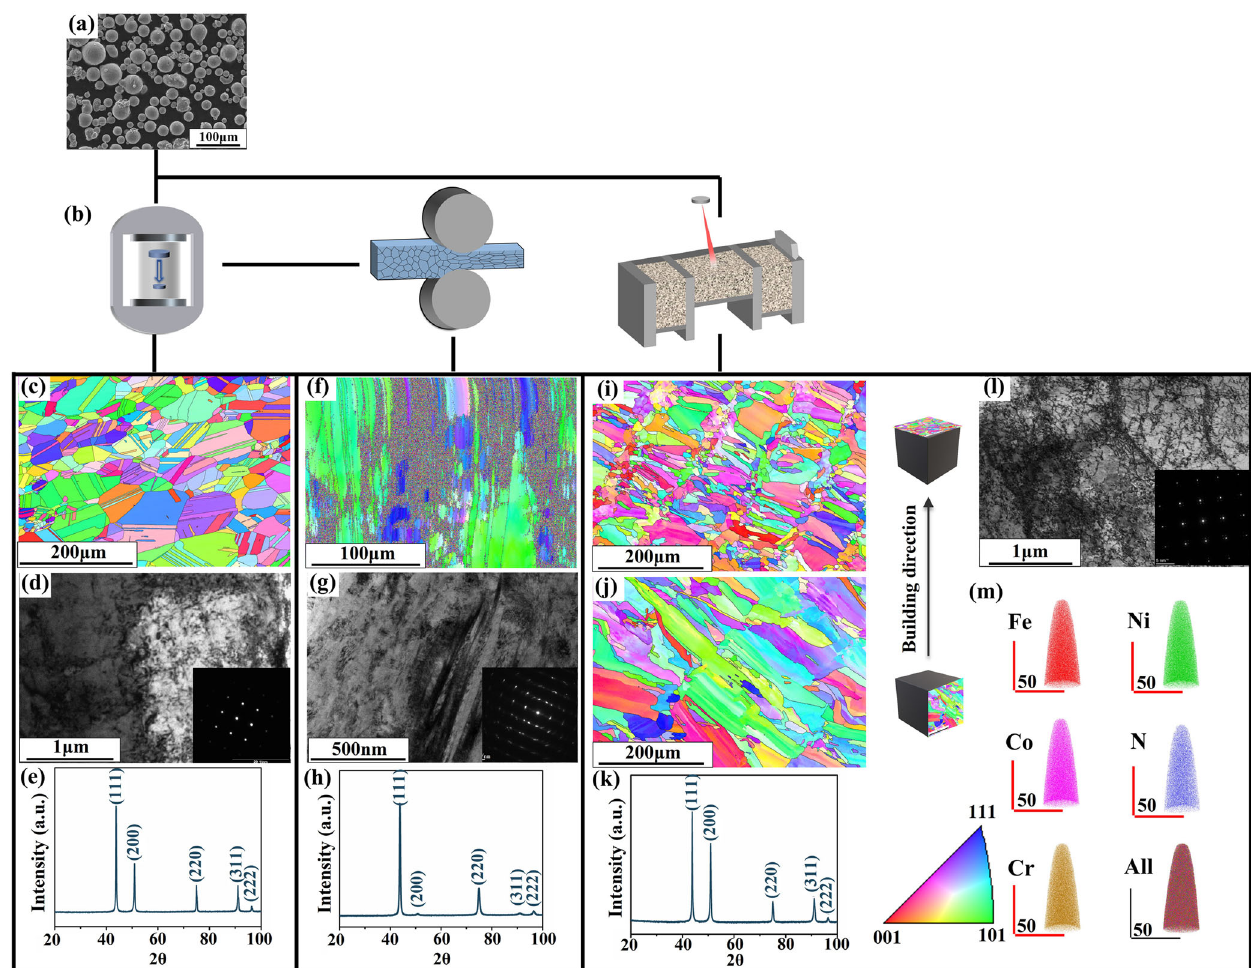
Fig. 1 Microstructures of the CoCrFeNiN 0.07 HEA. a Morphology of HEA raw powder. b A schematic of three different kinds of processing routes. c , f Electron backscatter diffraction (EBSD) inverse-pole maps of HIP and CR. i , j EBSD inverse-pole maps of SLM from cross-section vertical and parallel to the build direction. d , g , l A bright- fi eld transmission electron microscopy (TEM) image and the corresponding selected area electron diffraction (SAED) patterns of HIP, CR, and SLM samples. e , h , k X-ray diffraction patterns of HIP, CR, and SLM samples. m Three- dimensional (3D) reconstructions of a typical atom probe tomography (APT) tip showing atomic maps of Fe, Co, Cr, Ni, and N in the SLM